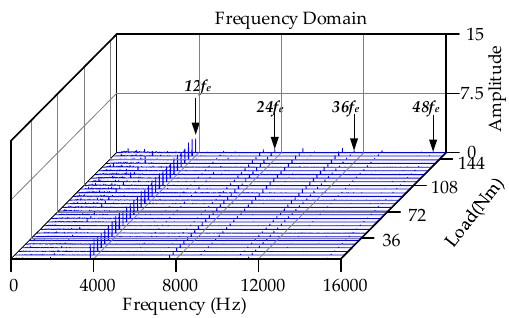
Figure 20. Waterfall diagram of electromagnetic torque.